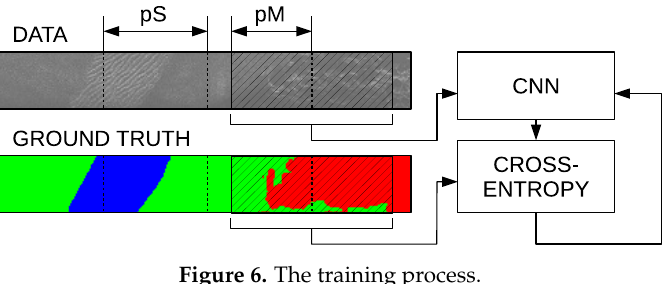
Figure 6. The training